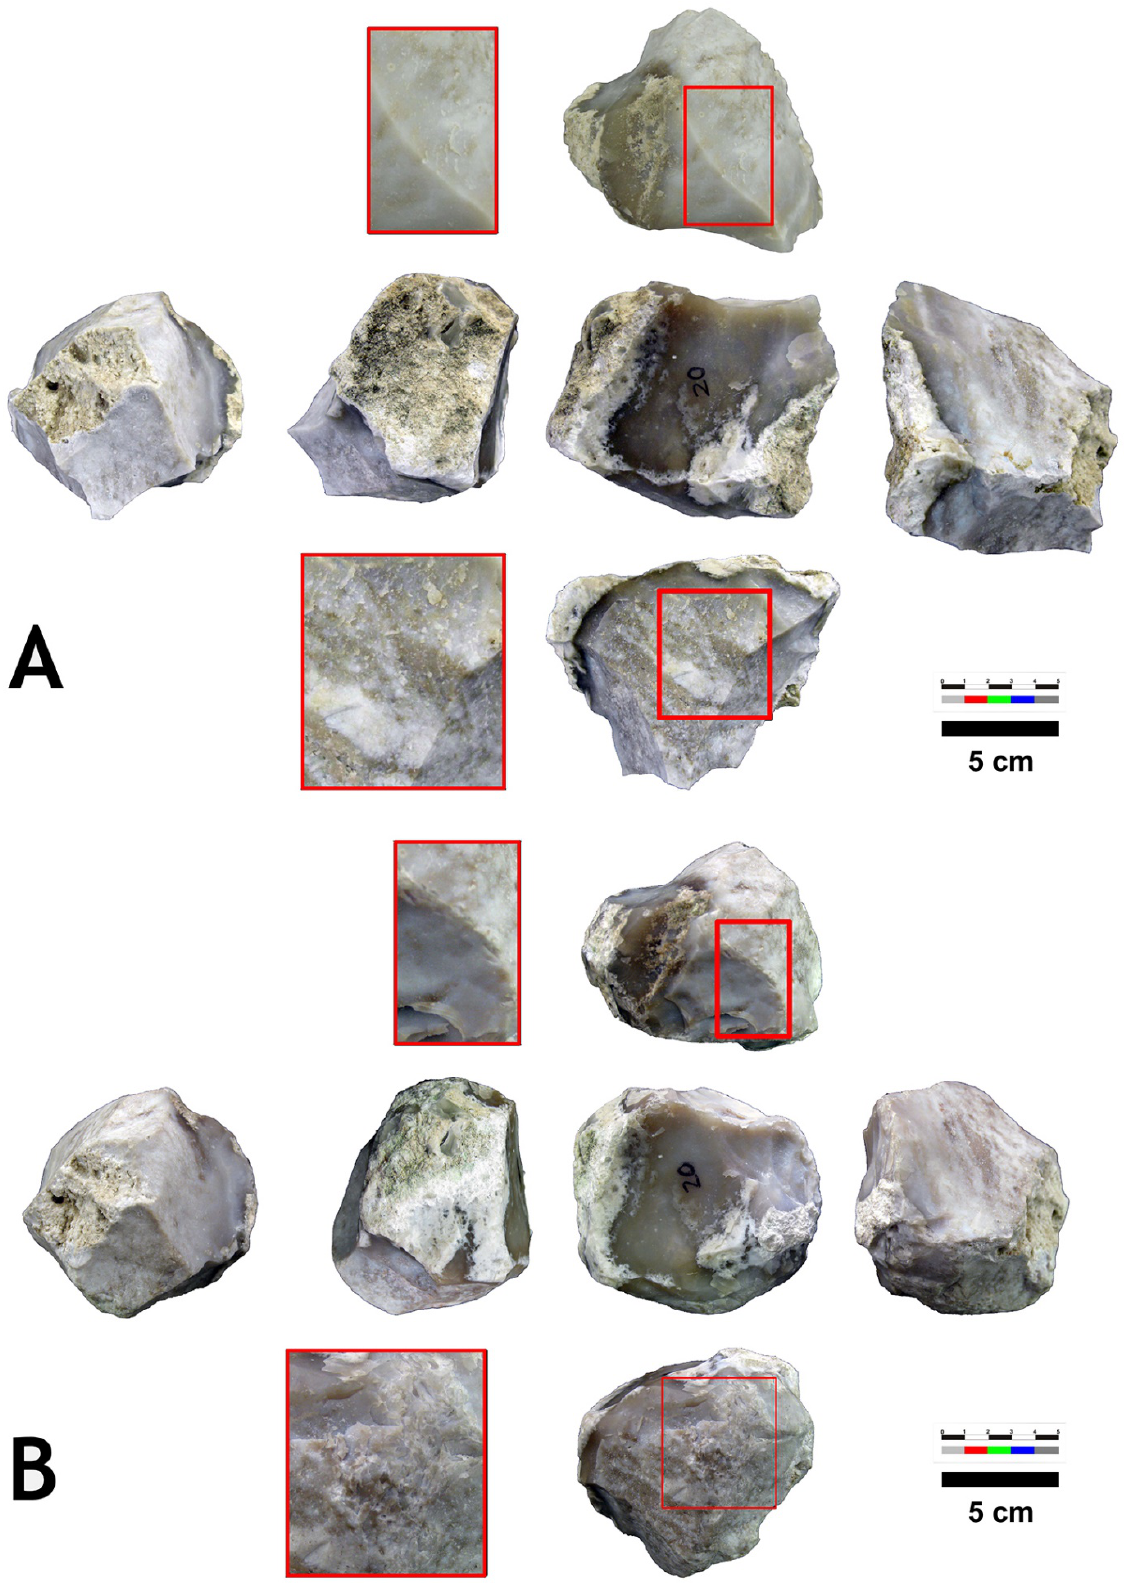
Figure 2. Experimental flint hammerstone before (A) and after use (B). Softening of the edges as preparation for use can be observed (upper rectangle and close-up), as well as the AZP (lower rectangle and